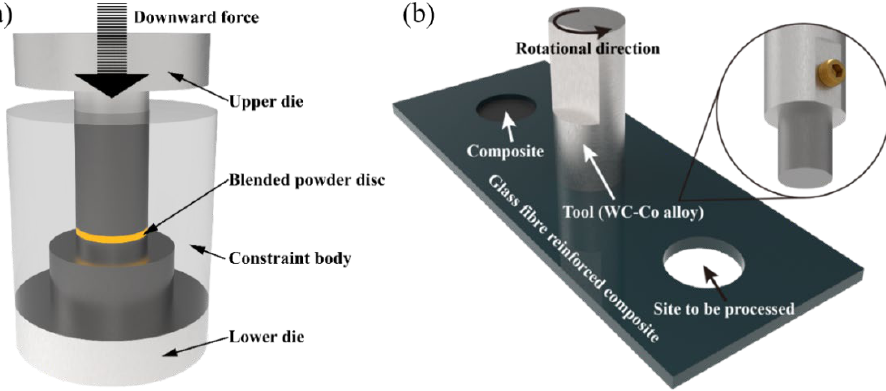
Figure 1. Preparation route of the CNTs/PEEK composites: ( a ) pre-compacting of the blended pow- der and ( b ) DDP process. powder and ( b ) DDP